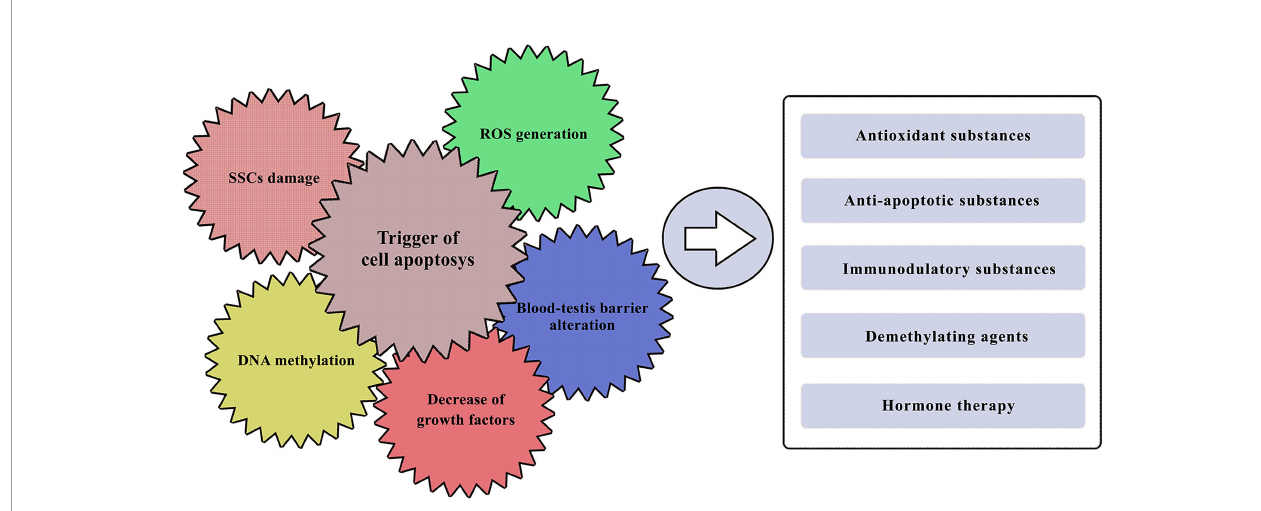
FIGURE 2 | Known gonadotoxic damage of cancer treatments and potential pharmacological approaches. On the left side: the major effects with which various chemotherapeutic agents could impair testicular function. On the right side: potential pharmacological approaches that have been tested so far, with more or less promising results in protecting the male